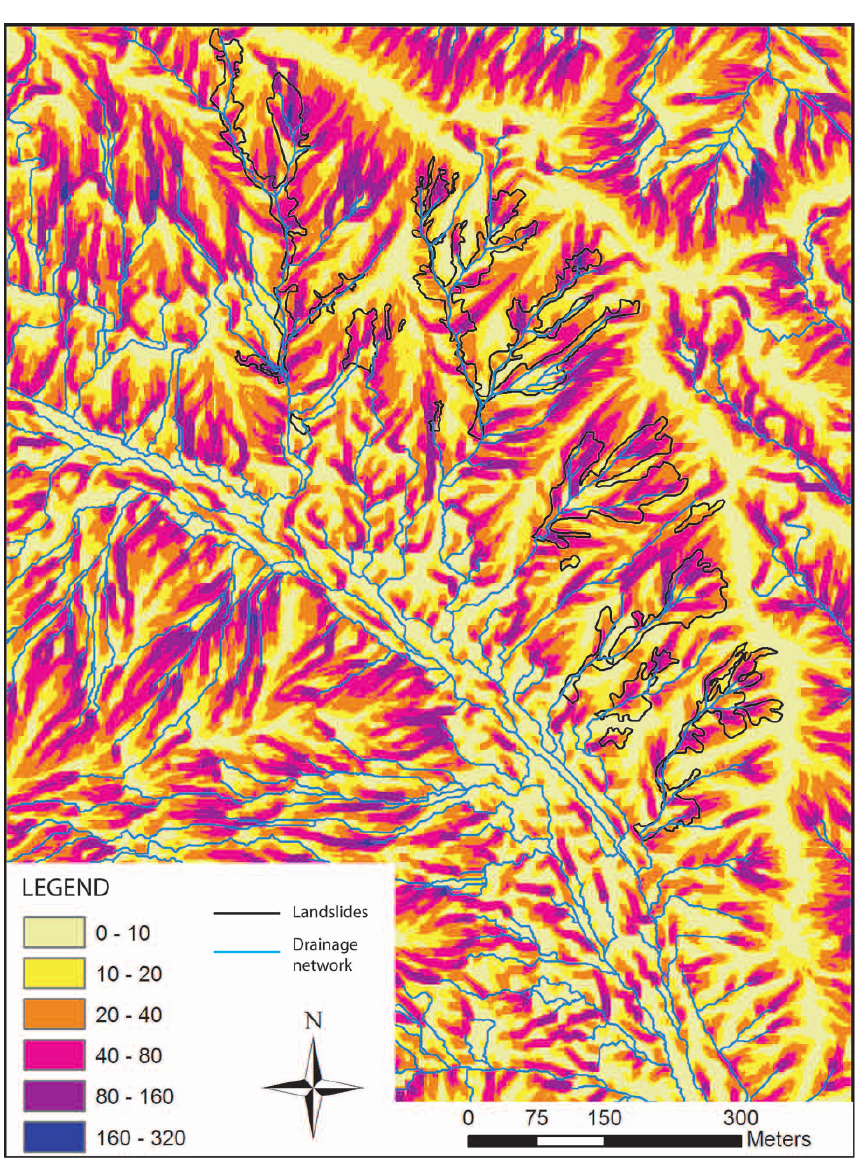
Fig. 9. Landslides drawn on the drained areas map of